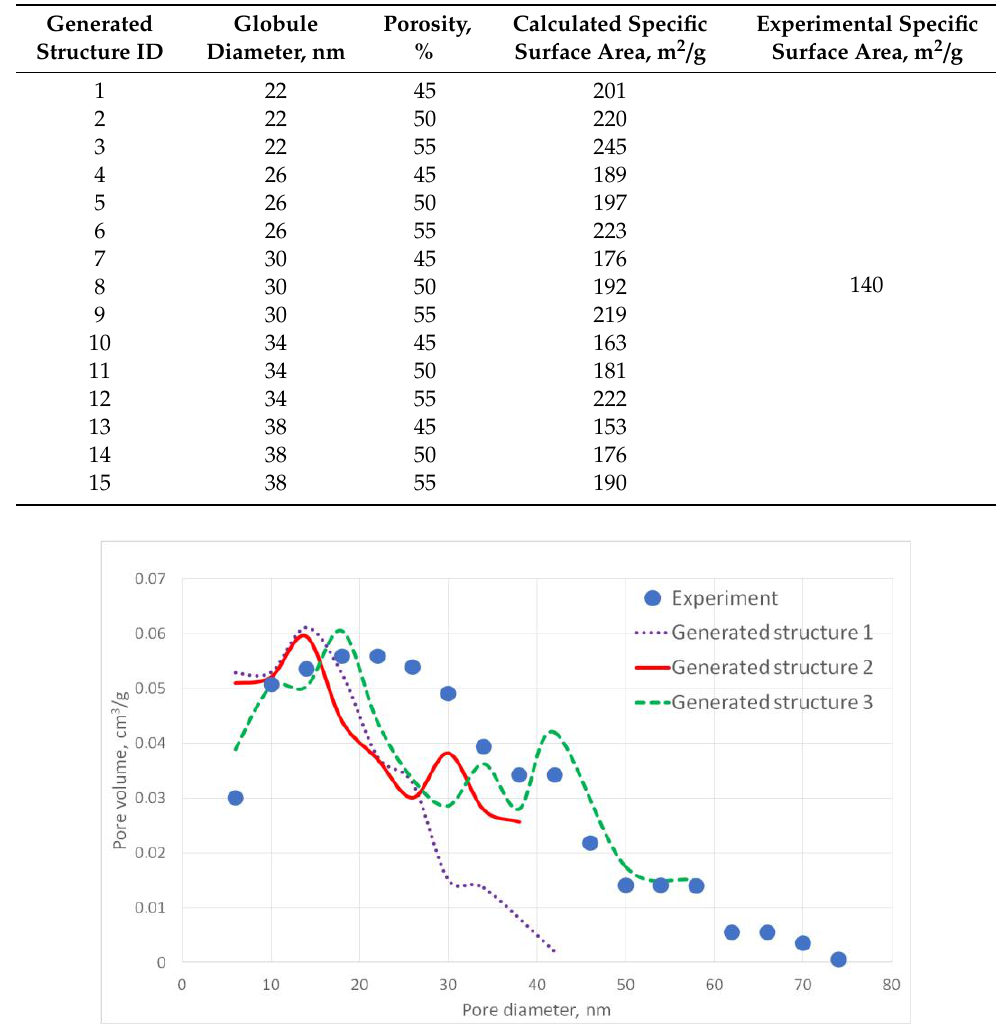
Figure 2. Pore size distribution curves for generated PA structures 1–3.